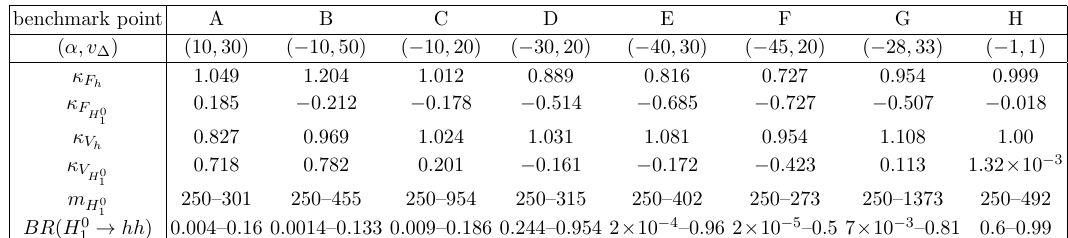
! hh ) > 0 and m > 250 GeV. H 0 1 1